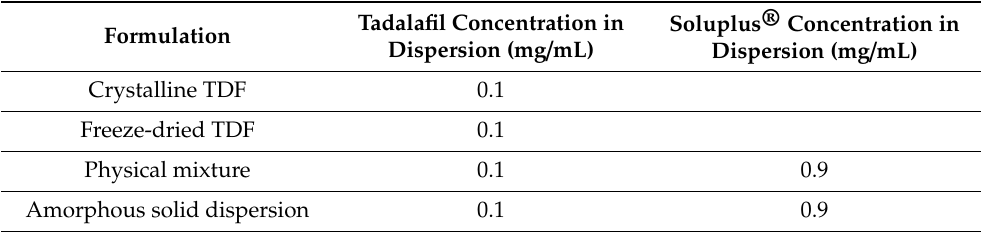
Overview of tadalafil formulations / dispersions used in the high-throughput formulation